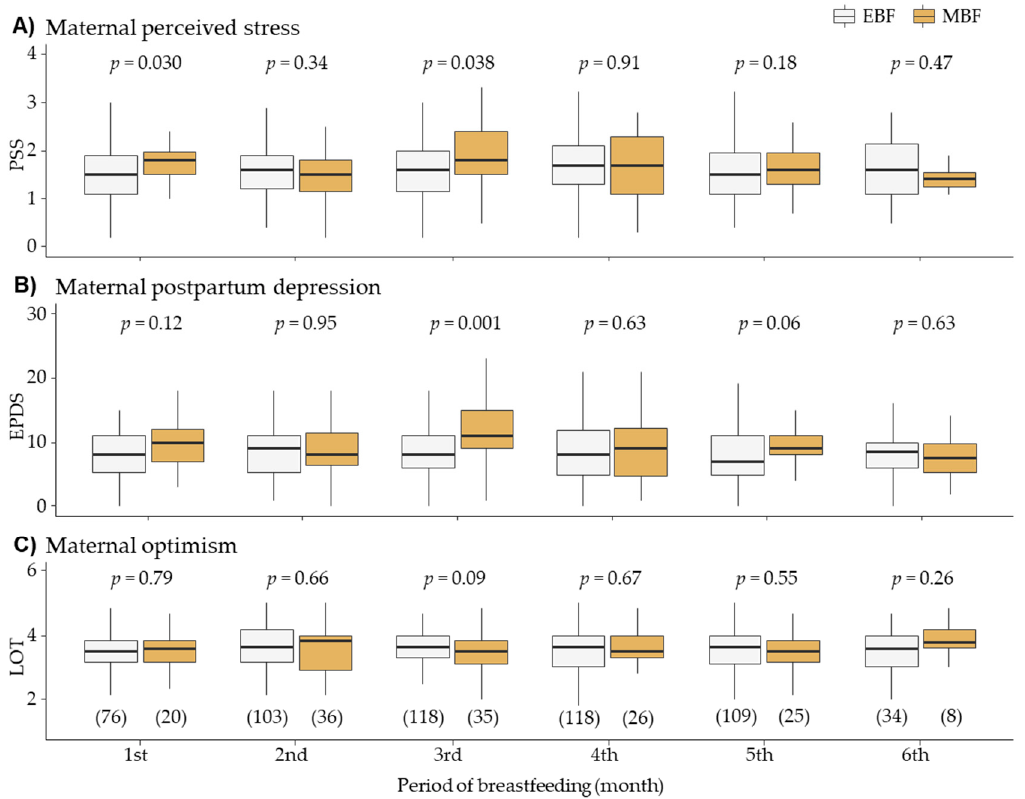
Figure 2. Evolution of psychological factors during the breastfeeding period stratified by infant exclusive breastfeeding (EBF) or mixed breastfeeding (MBF). ( A ) Perceived Stress Scale (PSS). ( B ) Edinburgh Postpartum Depression Scale (EPDS). ( C ) Life Orientation Test (LOT). Data show median and interquartile range. Sample size is shown between brackets. The p -Value was obtained by Wilcoxon sum-rank test.